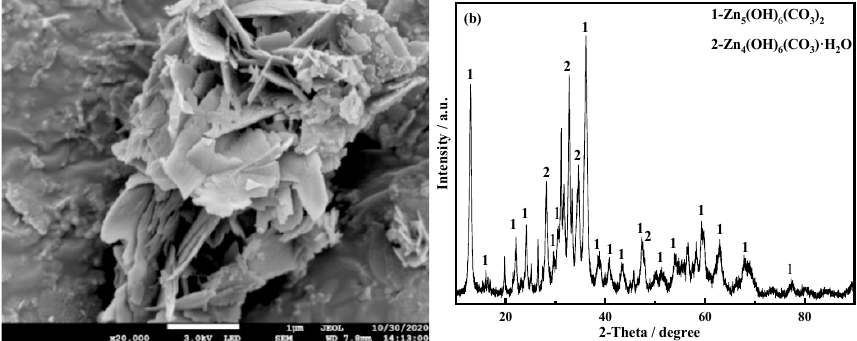
Figure 8. SEM ( a ) and XRD ( b ) of the purified solution dried at 90°C for 25 min.